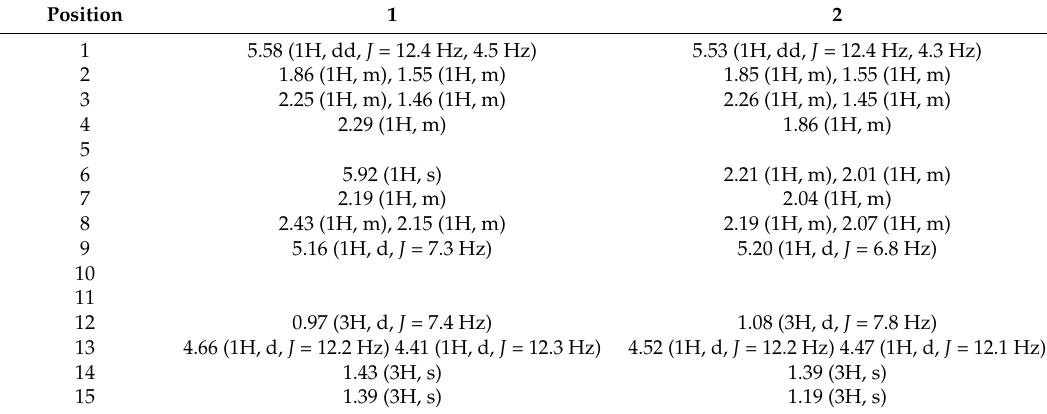
Table 2. 13 C ‐ NMR Spectroscopic Data of 1 and 2 (150 MHz, CDCl 3 ) a .